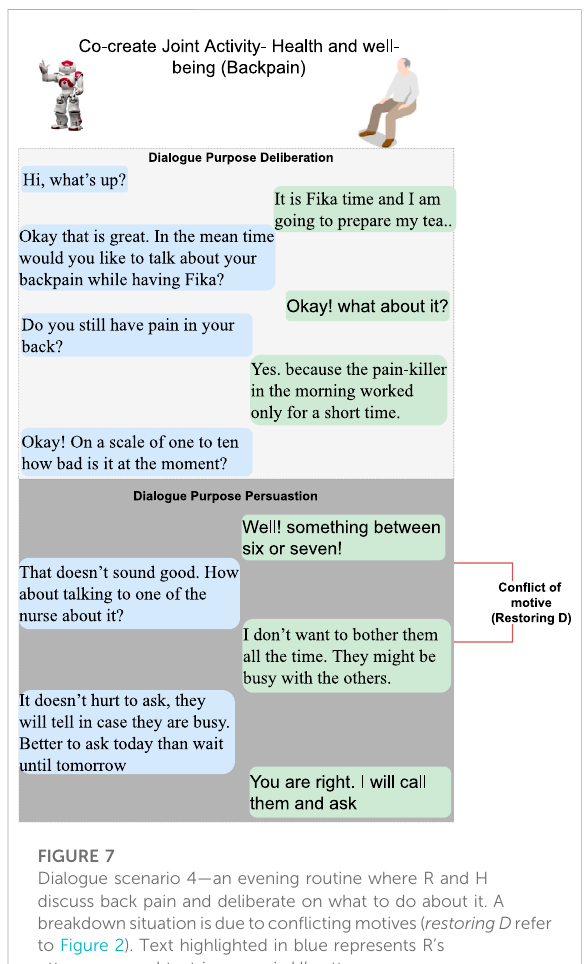
FIGURE 7 Dialogue scenario 4 — an evening routine where R and H discuss back pain and deliberate on what to do about it. A breakdownsituationisduetocon fl ictingmotives( restoringD refer to Figure 2). Text highlighted in blue represents R ’ s utterances, and text in green is H ’ s utterances.